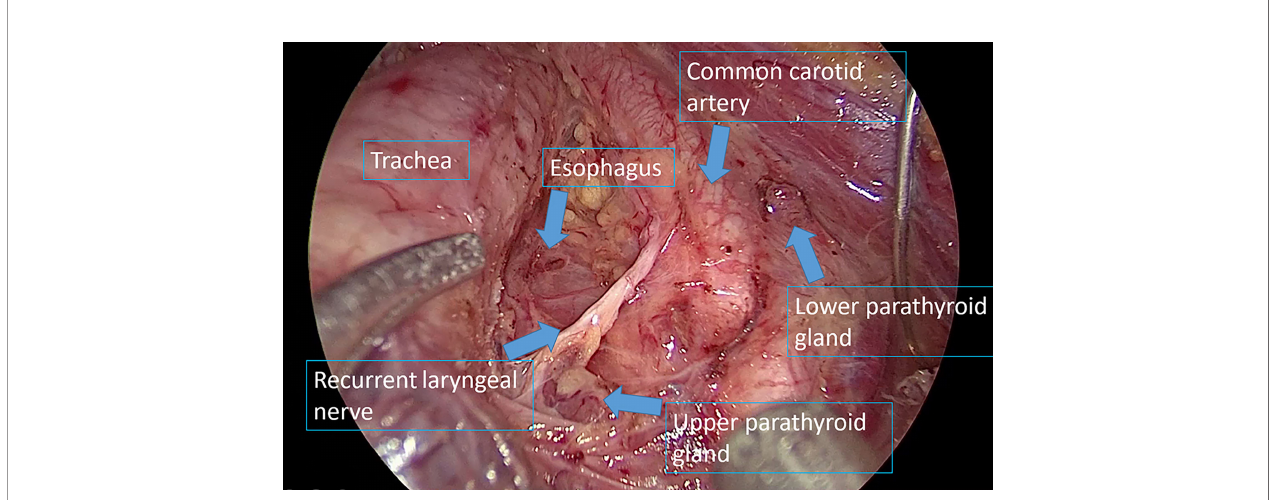
FIGURE 4 | Surgical fi eld after central lymph node